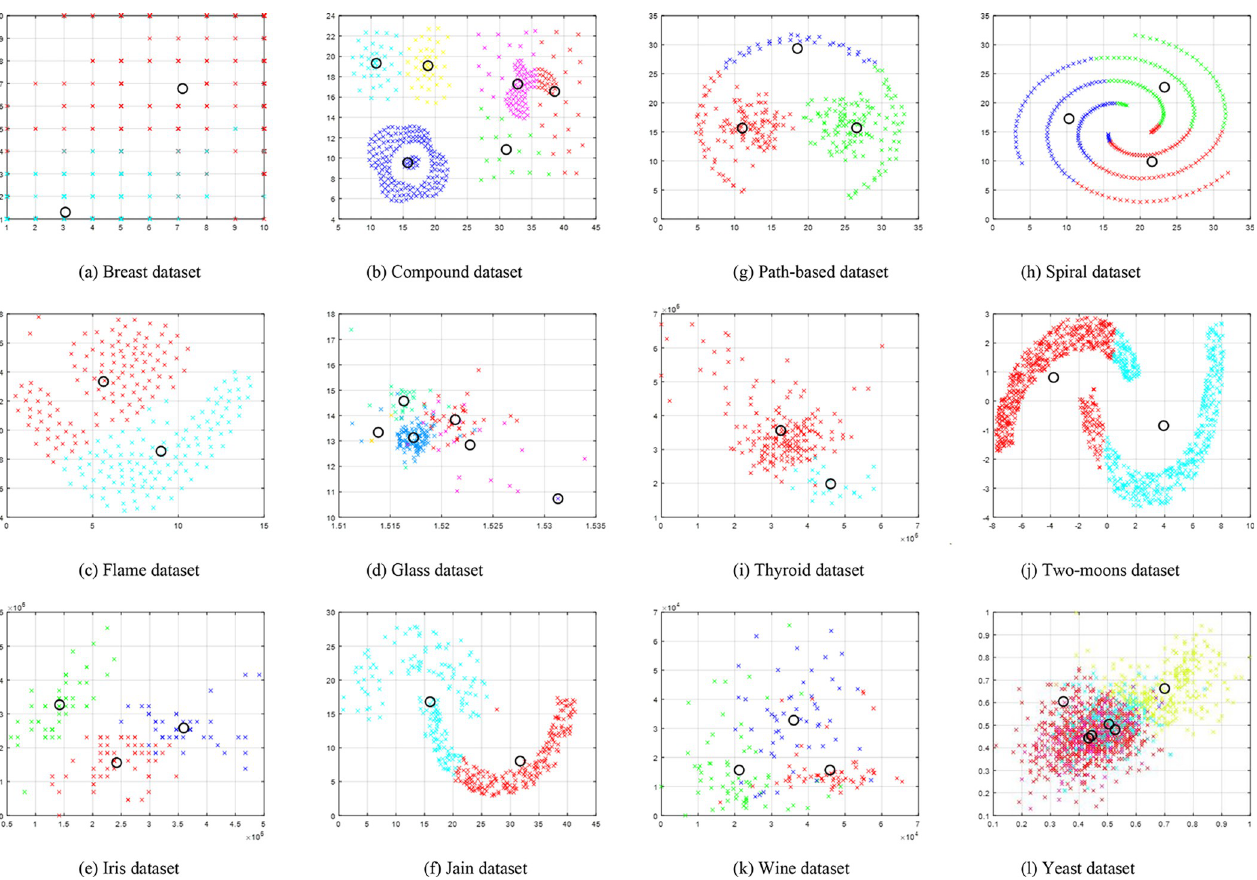
Fig 4. Clustering illustration of hybrid SOSK-means for the listed datasets using CS-Index.